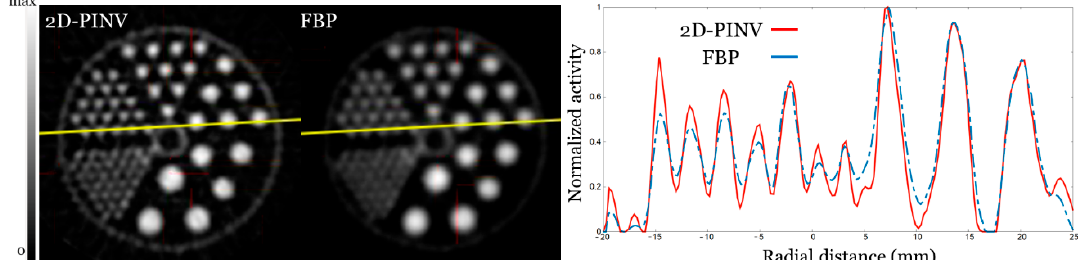
Figure 8. Five centimeter diameter Derenzo phantom. Rods were 1.2, 1.6, 2.4 3.2, 4, and 4.8 mm in diameter. ( Left ) Reconstructed with 2D-PINV and FBP, respectively, from same sinogram rebinned with FORE. We show the 10 axial slices summed up. ( Right ) Profile along the yellow line showing the 1.6 and 3.2 mm rods.